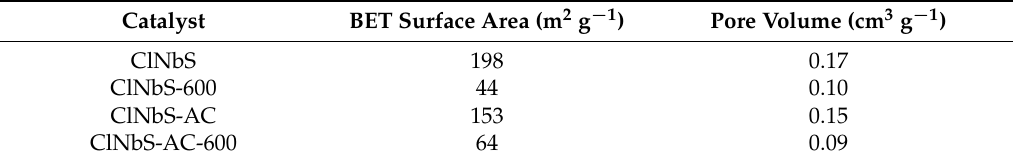
Figure 2. N 2 adsorption/desorption of the catalysts.